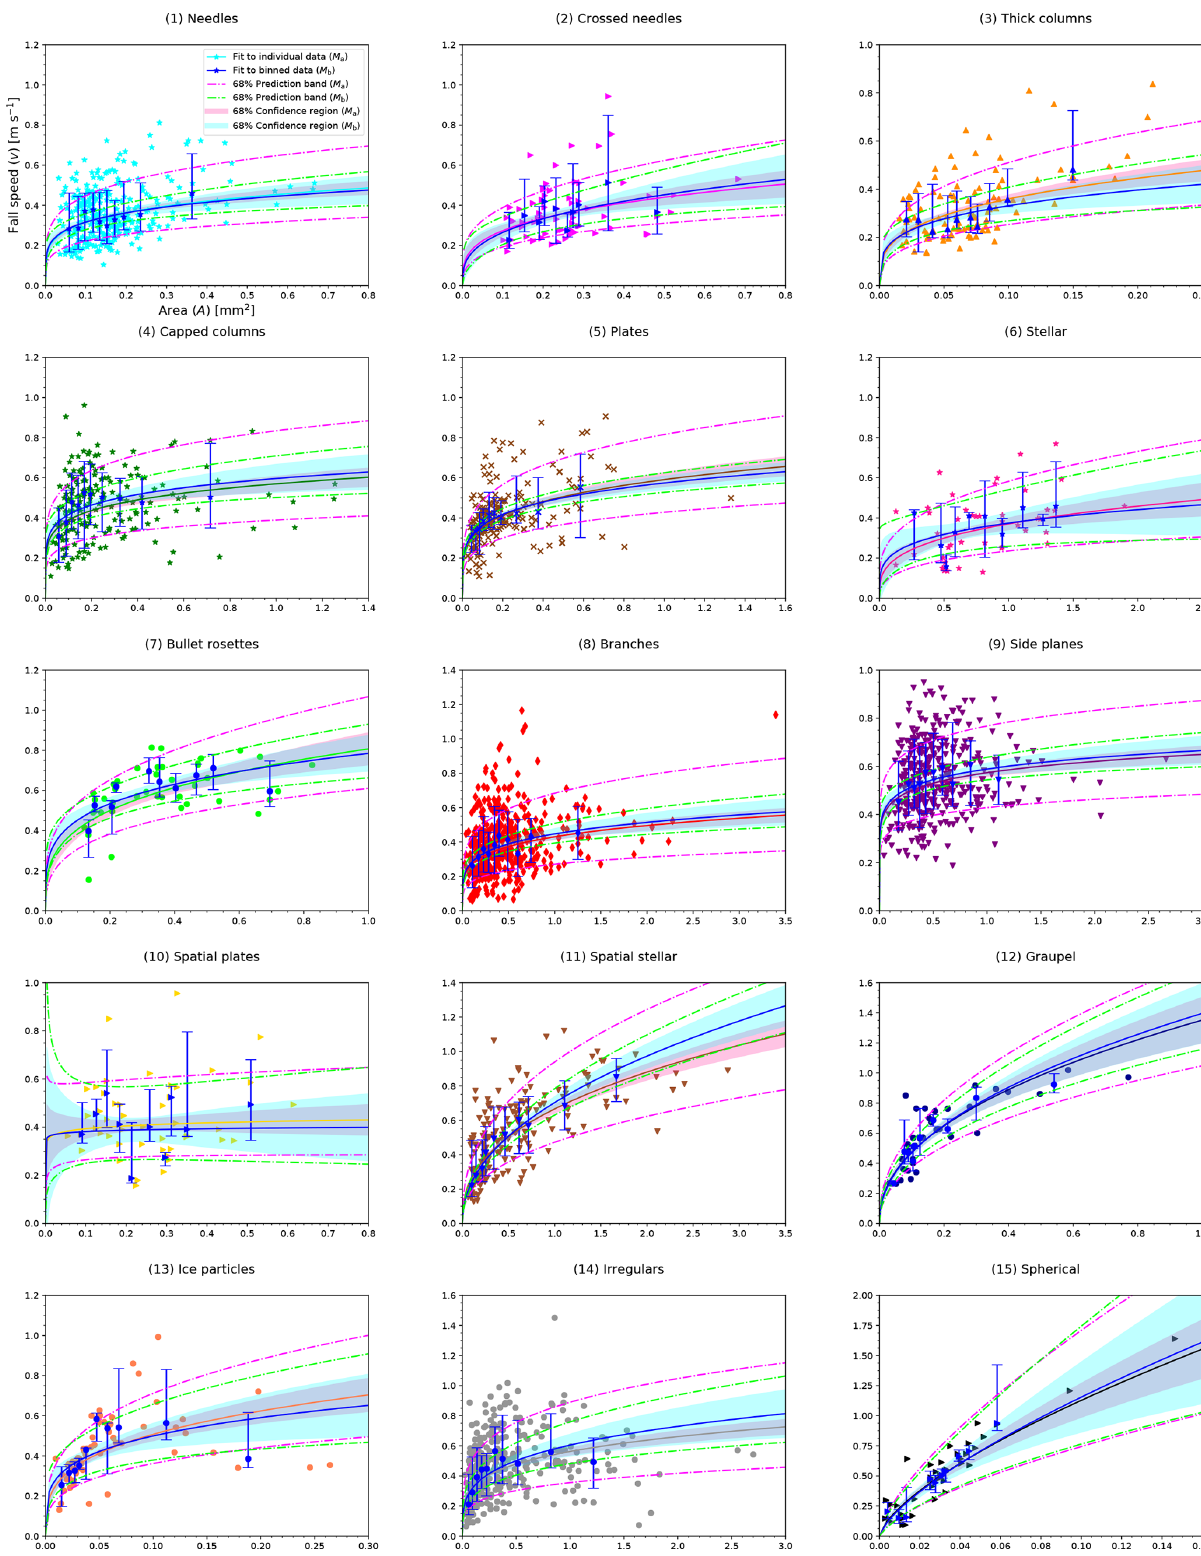
Figure A2. Same as for Fig. A1, but fall speed vs. cross-sectional area ( v vs. A ) relationships given by Eq. (5) are shown